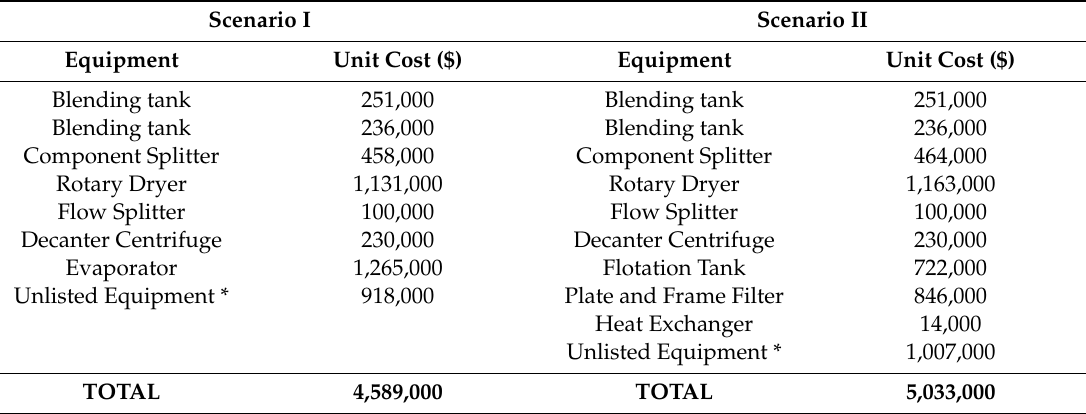
Table 3. Equipment costs for conventional ethanol production (Scenario I) and flocculation system